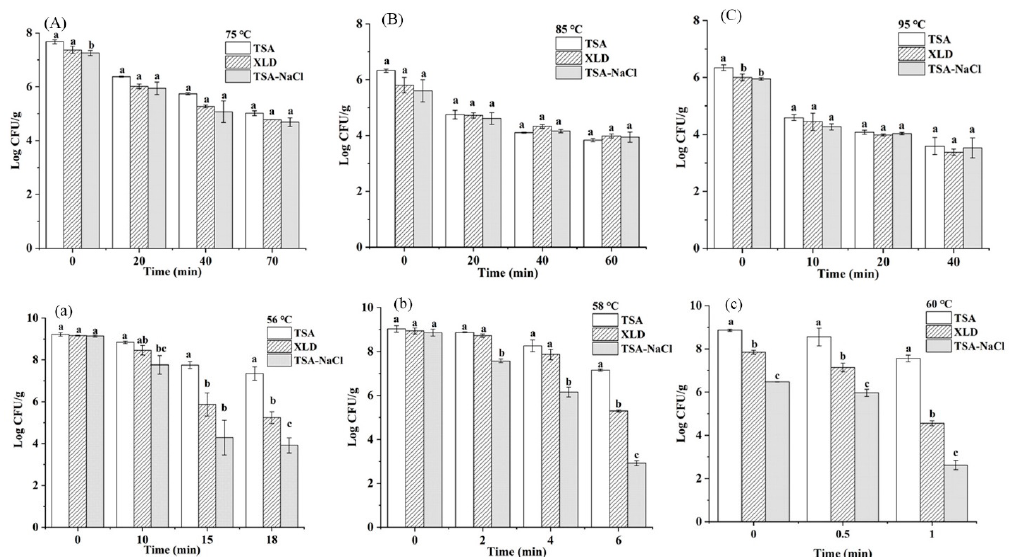
Figure 3. Population of S. Montevideo CICC21588 in undiluted tahini ( A – C ) and diluted tahini ( a – c ) grown on TSA, XLD and TSA-NaCl plates at different treatment temperatures. The same low case letter among different plates at each treatment indicates values are not significantly different ( p > 0.05).